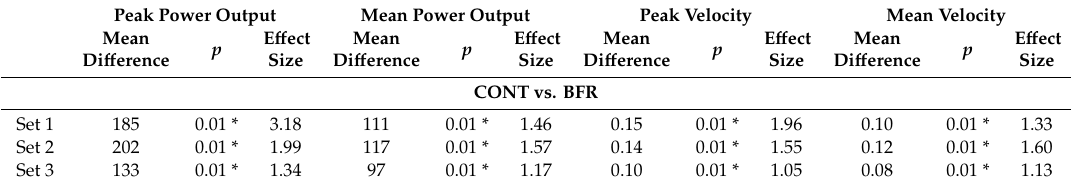
Table 4. A comparison in individual sets between conditions based on t-test